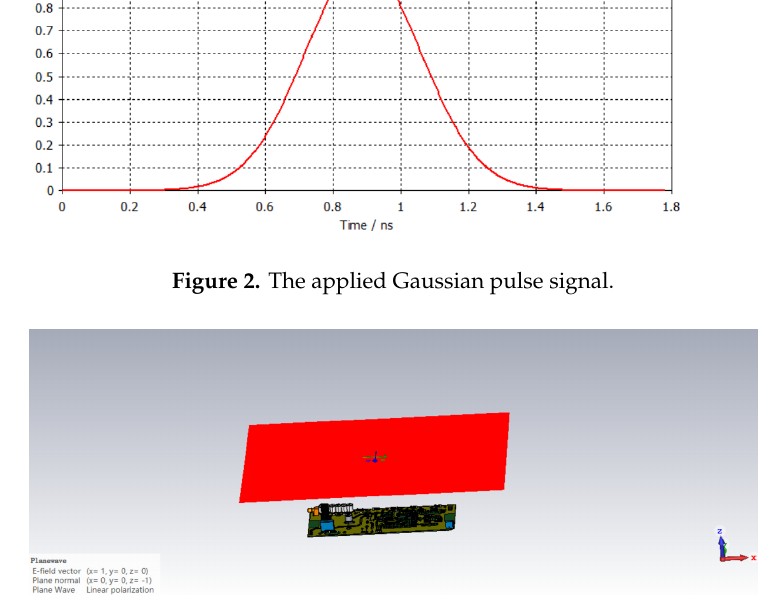
Figure 3. Simulation model of far-field disturbance.